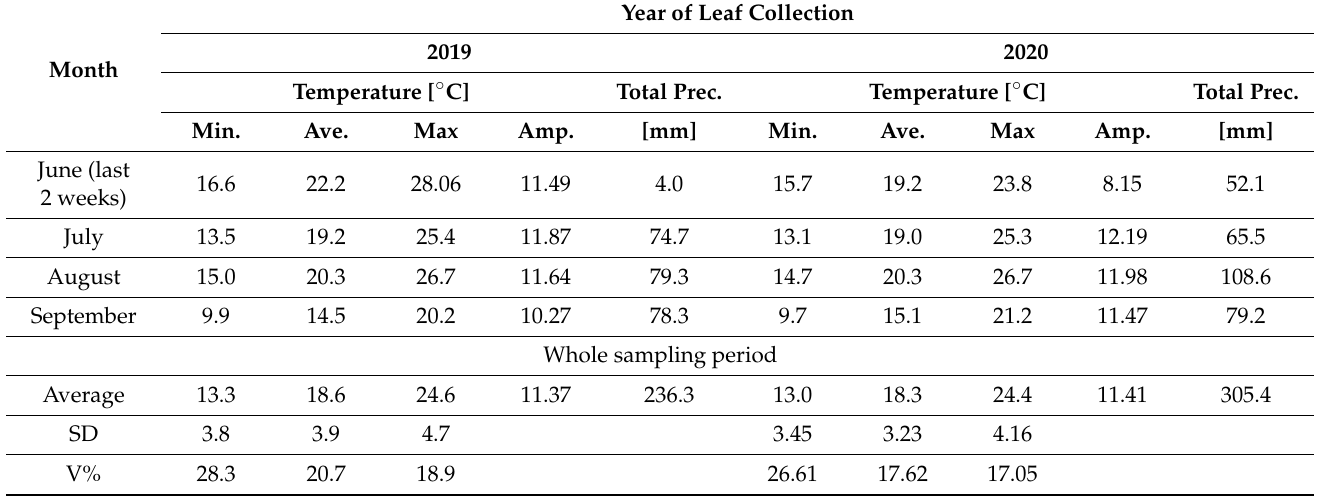
Table 1. Temperature and precipitation profile during the 2019 and 2020 sampling